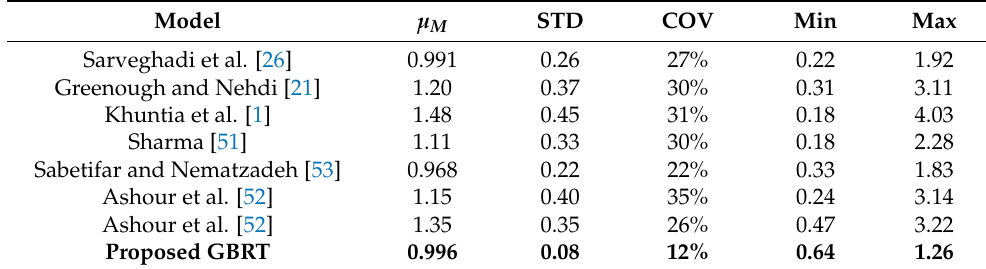
Table 5. Statistical measures of the proposed equations.